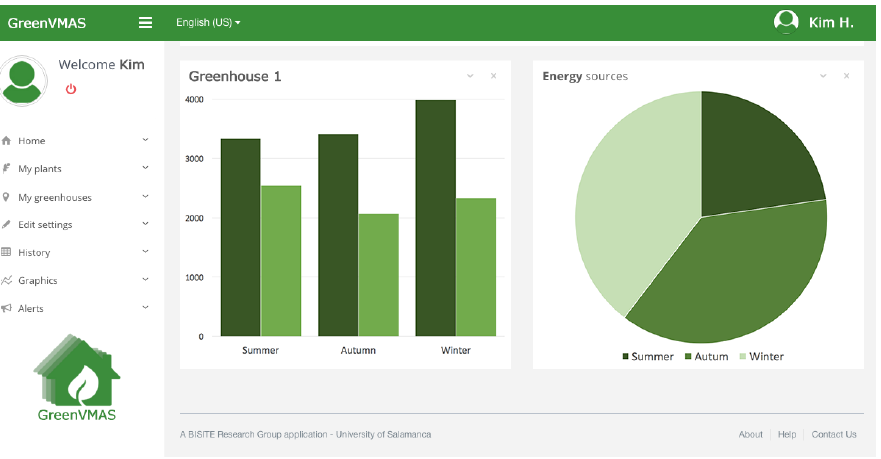
Figure 4. Final user software web application: in this case charts display performance and energy